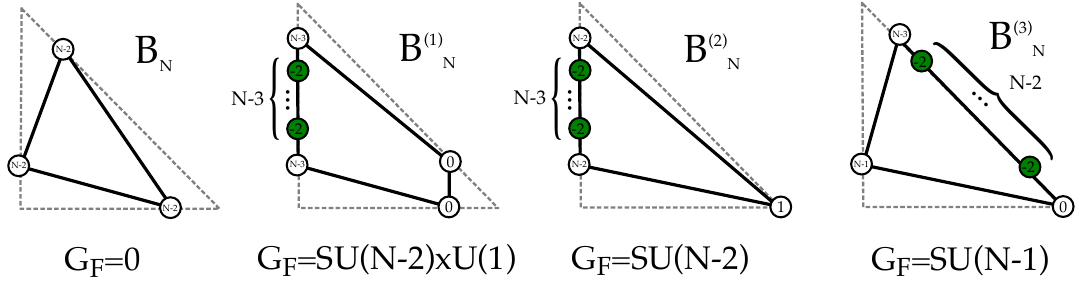
Figure 13 . CFDs (and toric diagrams) for all RG-(cid:13)ow tree endpoints for T N . G F is the (cid:13)a- vor symmetry and each of these models has no further descendant, and also no IR-gauge theory